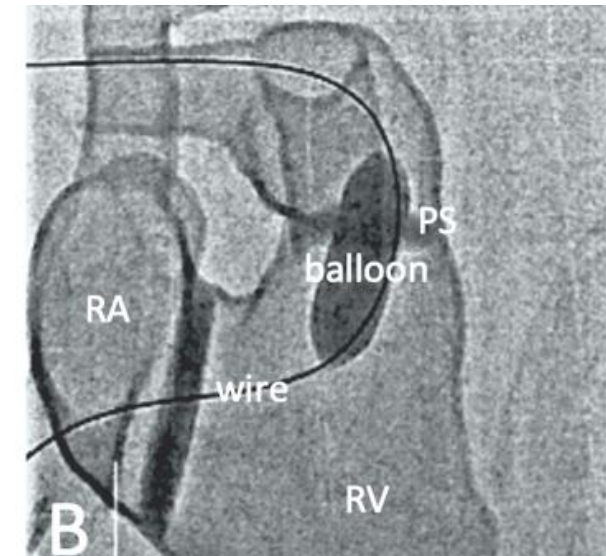
Figure 13. Example of simulation of Tetralogy of Fallot repair on a 3D-printed heart model. Re- printed with permission under the open access from Hon et al. [89].